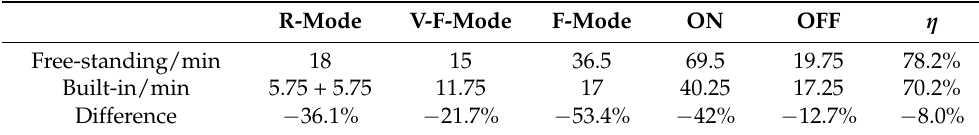
Figure 10. Comparison of the power and temperature of FC, VC, and RC during on/off cycle. The running time of each period is displayed in Table 8. The results show that the running time of the built-in refrigerator in each period is shorter than that of the free- standing one. The ON-time ratio of compressor 𝜂 also decreases from 78.2% to 70.2%. This is because, as mentioned above, a lower evaporating temperature brings about the increase in the cooling rate of compartments. However, the power during the compressor-on period greatly increases to make it at the same time. Table 8. Comparison of running time in each period during on/off cycle.